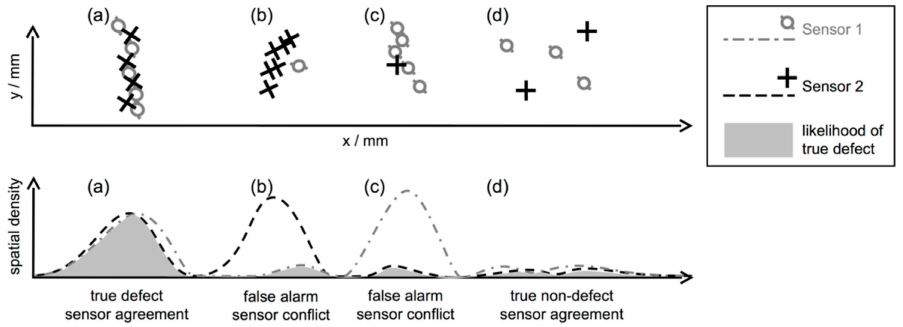
Figure 1. Schematic representation of the principle of the approach. The detection outcomes of two different NDT methods are represented by circles and crosses, for four cases (a)–(d). For each case, the corresponding spatial density per sensor along the x -axis is plotted below. The likelihood of observing a true defect (gray area) depends on both sensors yielding significant hit